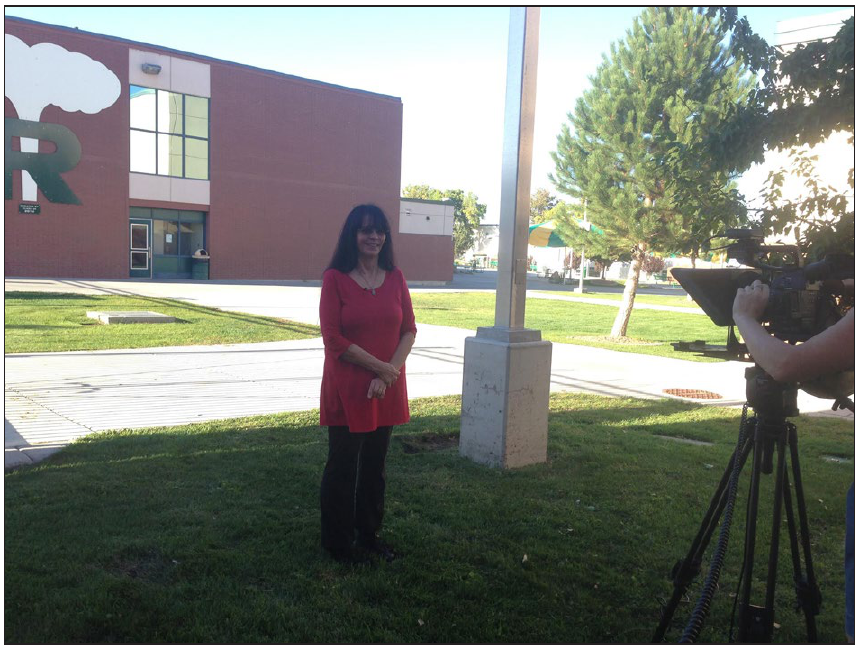
Figure 27: Irene Lusztig, Production still from Yours in Sisterhood single channel video and web archive (work